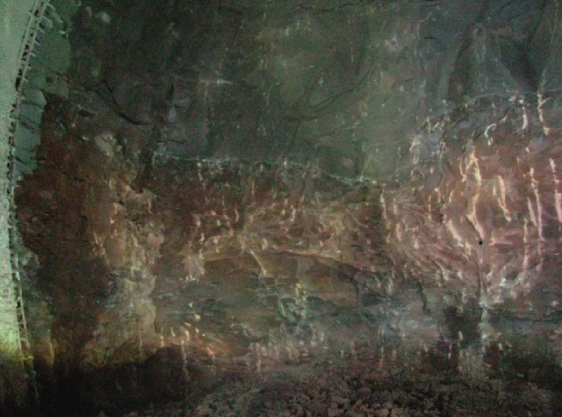
Figure 10: The actual contour at DK247+ 047.5.